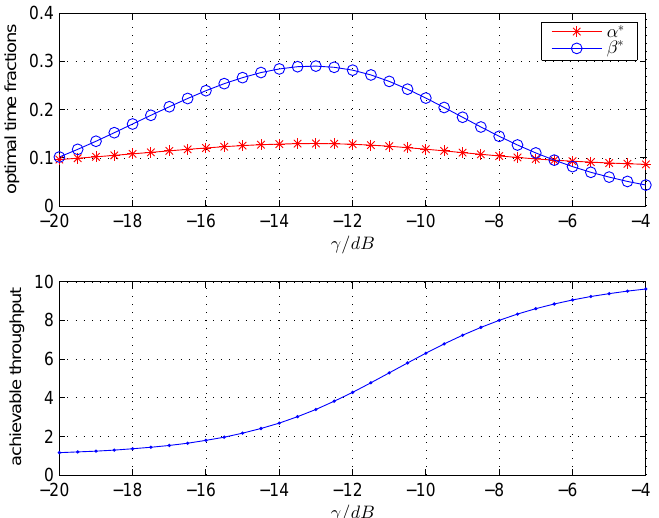
Figure 3. The optimal α ∗ , β ∗ and achievable throughput versus γ .